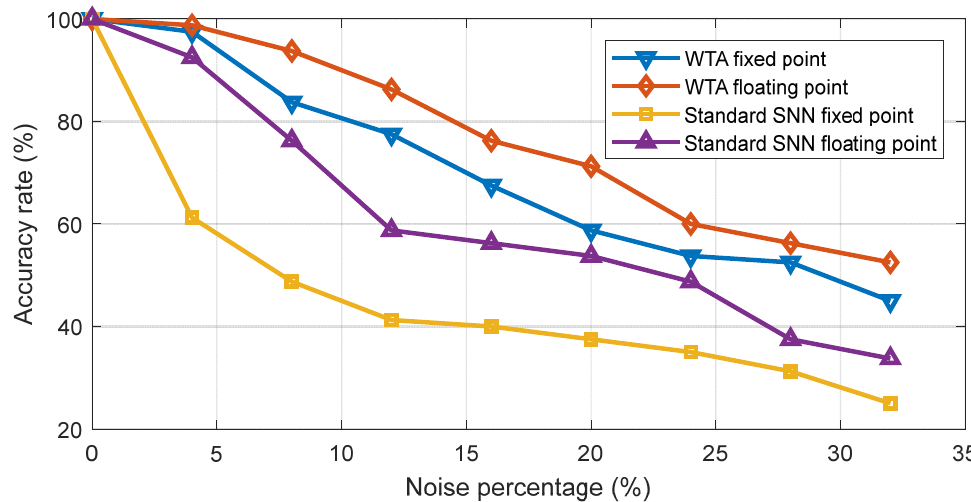
Figure 12. Recognition accuracy rate between di ff erent types of neural networks.